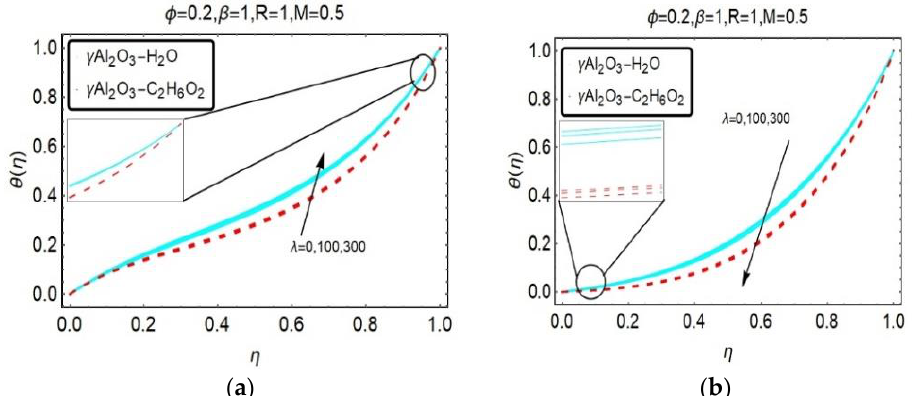
Figure 18. Influence of 𝑀 2 on 𝜃(𝜂) for ( a ) 𝑆 > 0 and ( b ) 𝑆 < 0 .